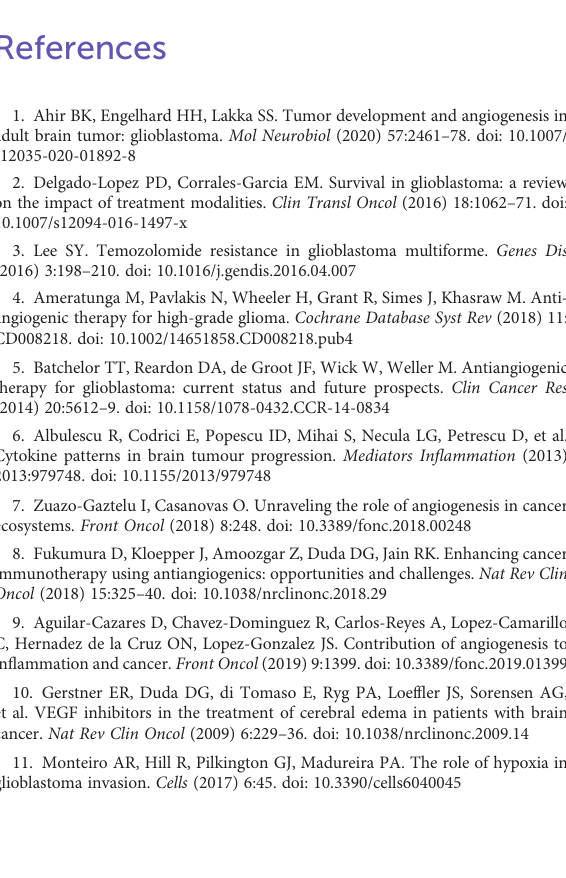
SUPPLEMENTARY FIGURE 1 – 3 Kaplan Meier Plots demonstrating the effect of gene expression on overall survival (OS) or disease-free survival (DFS) in GBM. Data is from The Cancer Genome Atlas (TCGA), accessed through GEPIA (http://gepia. cancer-pku.cn). Group cutoff for high expression vs. low expression of thegeneofinterestisthemedian.Hazardratio(HR)iscalculatedbasedon COX proportional hazards Model. Hazard ratios are for the “ high expression ” group for each gene, and refer to overall survival (OS) or disease-free survival (DFS). The presented hazard ratios and their respective 95% con fi dence intervals are shown as forest plots in Figure